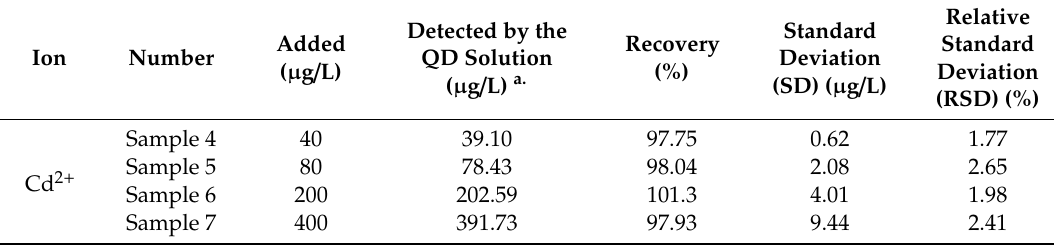
Table 3. Recovery of Cd 2 + from river water